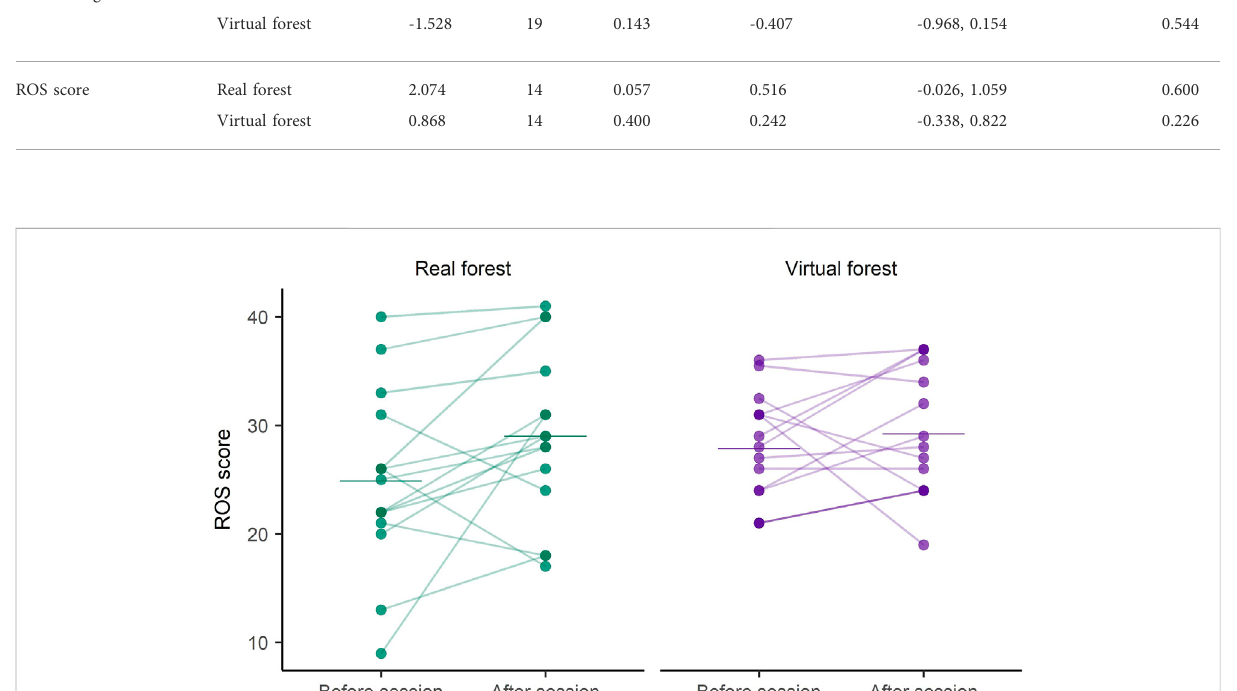
FIGURE 4 Individualchangeinrelaxation(ROSscore)splitbyvirtualandrealforestsessions.Eachlinerepresentsanindividualchange,andhorizontallines in the graphs are mean